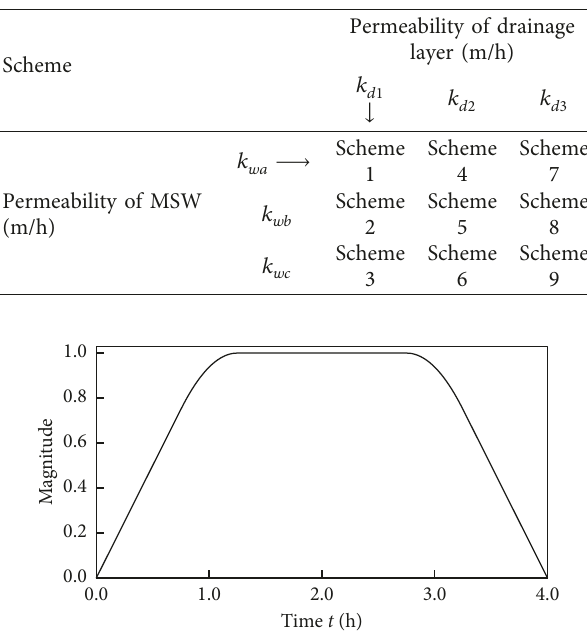
Figure 11: Amplitude curve of rainfall intensity.